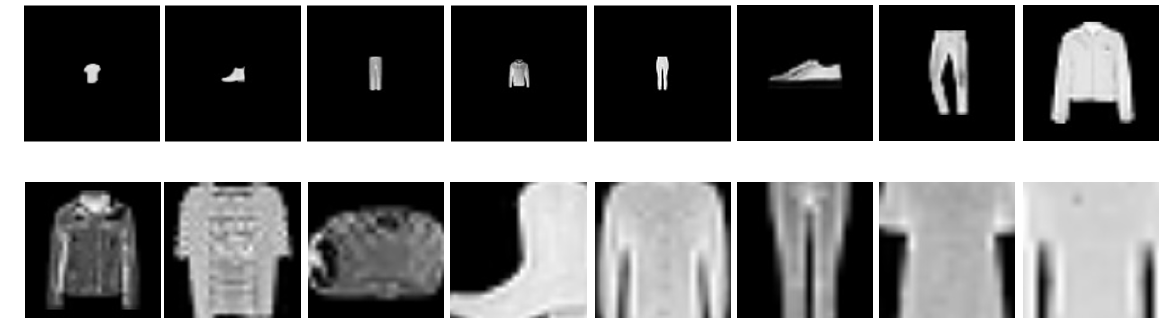
Figure 6. Images in the FMNIST Large Scale